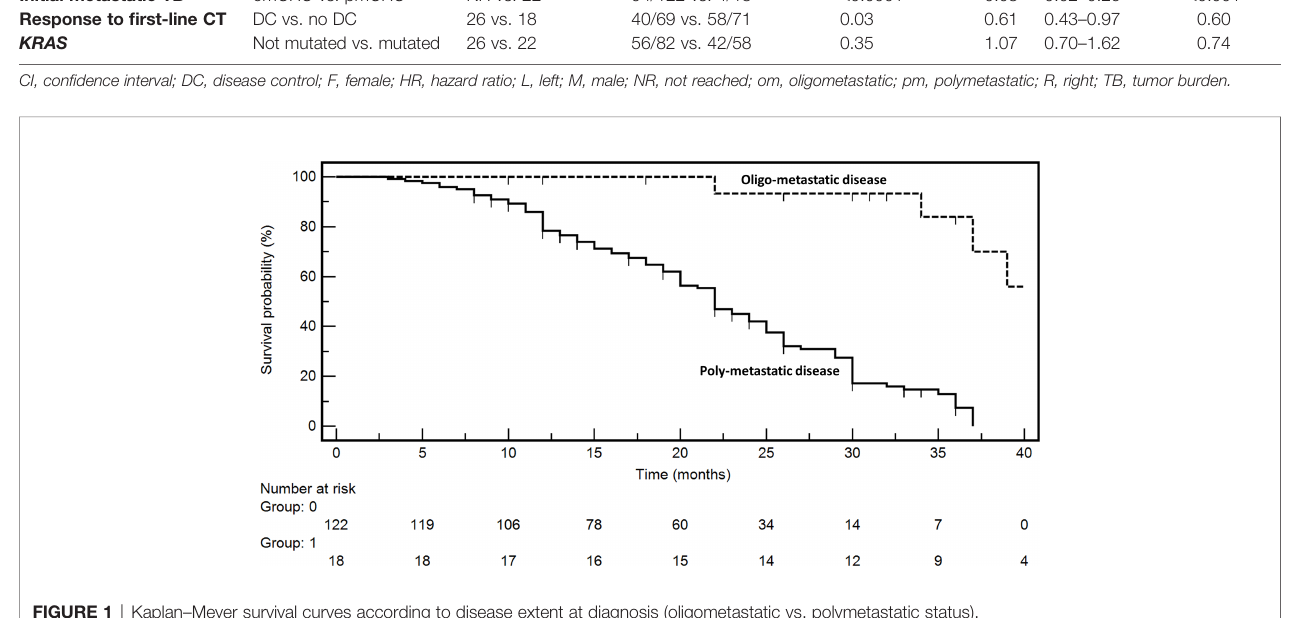
FIGURE 1 | Kaplan – Meyer survival curves according to disease extent at diagnosis (oligometastatic vs. polymetastatic status). TABLE 3 | Clinicopathological characteristics and genetic concordance of KRAS status in the oligometastatic